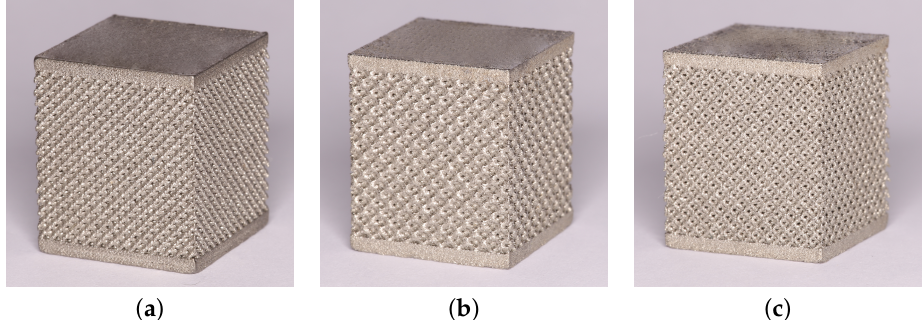
Figure 3. Examples of trabecular specimens made for compression tests: ( a ) D30-2, ( b ) DT-2, ( c ) RD30- 2 (Table 1).